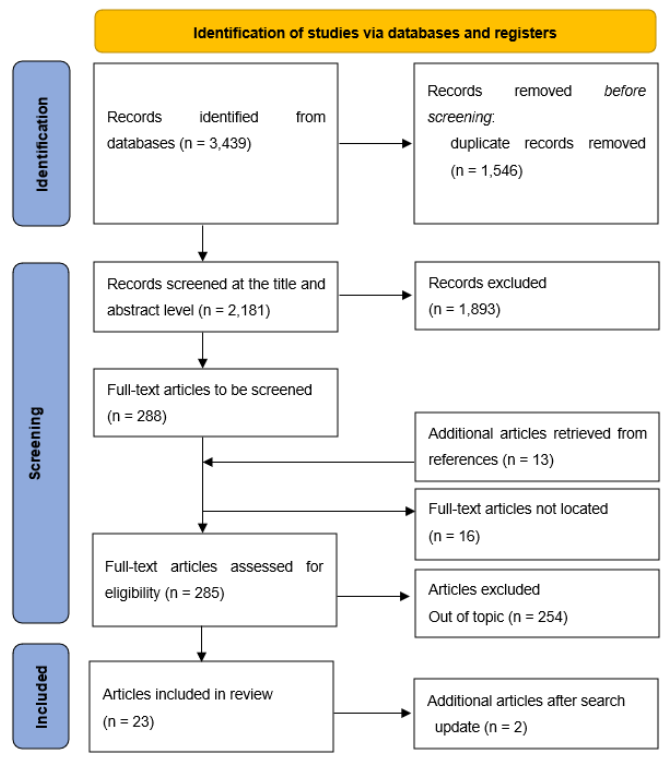
Figure 1. PRISMA flow